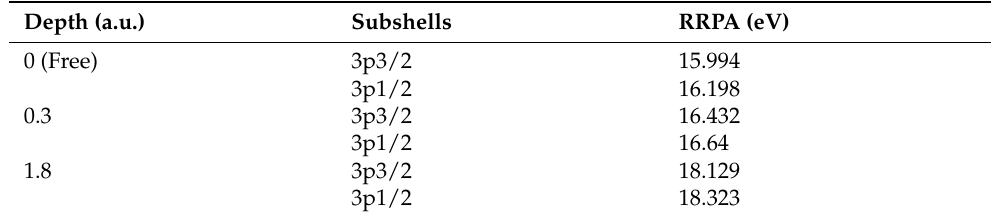
Table 1. 3 p subshell thresholds of free and confined Ar.